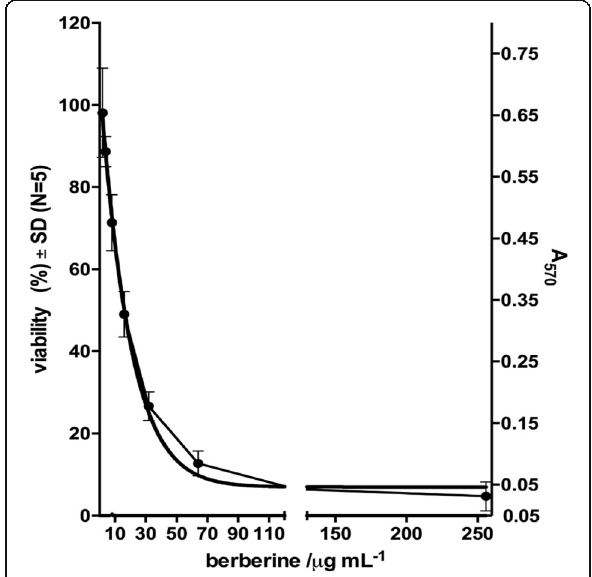
Fig. 2 Non-linear regression line assessing viability of C. albicans treated with berberine. The data are shown as means ±